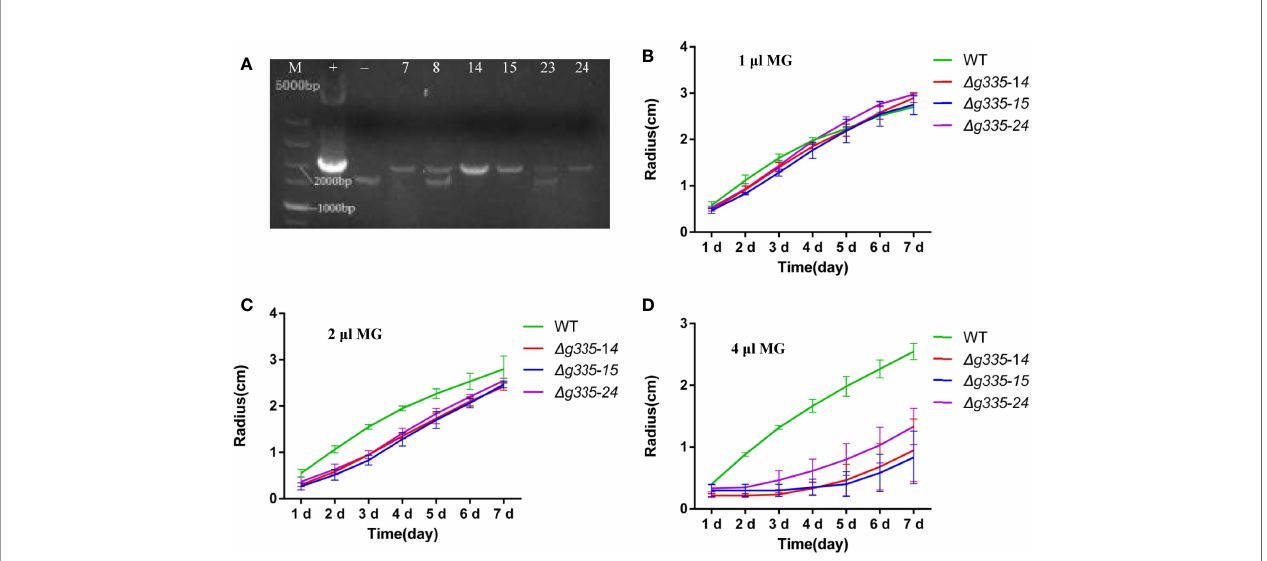
FIGURE 1 | Veri fi cation of AOL_s00004g335 knock-out mutants. (A) PCR veri fi cation of knock-out mutants. +, positive control. -, negative control. M, DNA marker. No. 14, 15, and 24 are positive transformants. (B – D) Veri fi cation of the knock-out mutants by measuring the hyphal growth on the TG medium containing different amounts of MG. 1, 2, 4 m l of MG solutions per 5 ml medium were used in (B – D) , respectively. WT, wild-type strain. D g335-14 , D g335-15 , and D g335-24 : AOL_s00004g335 knock-out